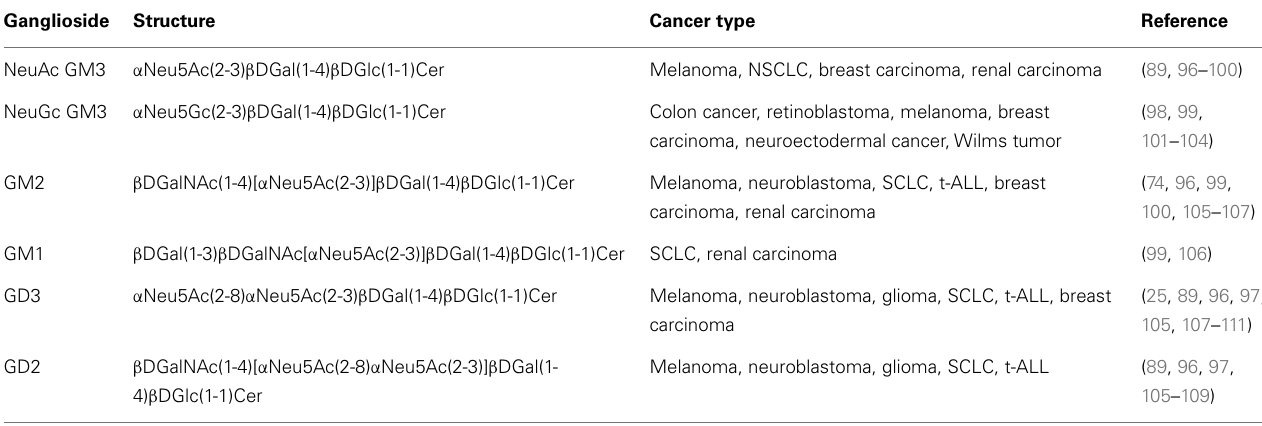
Table 2 | Gangliosides expressed in human cancer cells